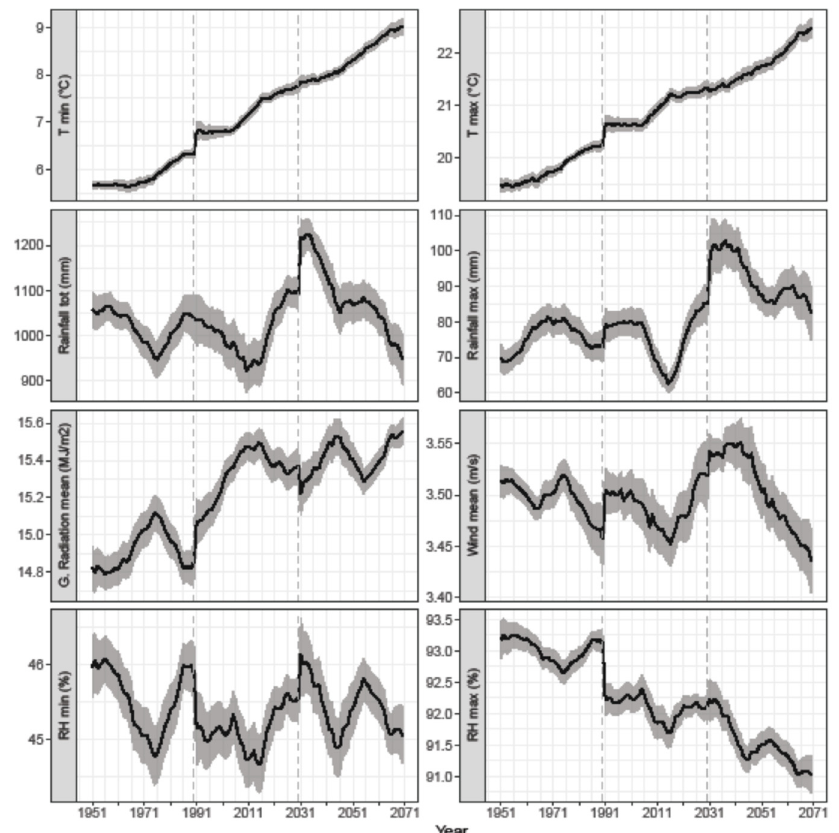
Figure 1. Predicted trends in annual temperature, relative humidity, rainfall, wind speed, and radiation over the simulated period. Mean of the minimum and maximum daily relative humidity and temperature; total annual and largest annual daily rainfall, mean daily mean wind speed, and sum of global radiation. Vertical dashed lines separate time in periods corresponding to the simulated scenarios. Discontinuities between periods are due to the fact that moving averages are applied to individual series of forty years. Vertical lines represent the 95% confidence interval.